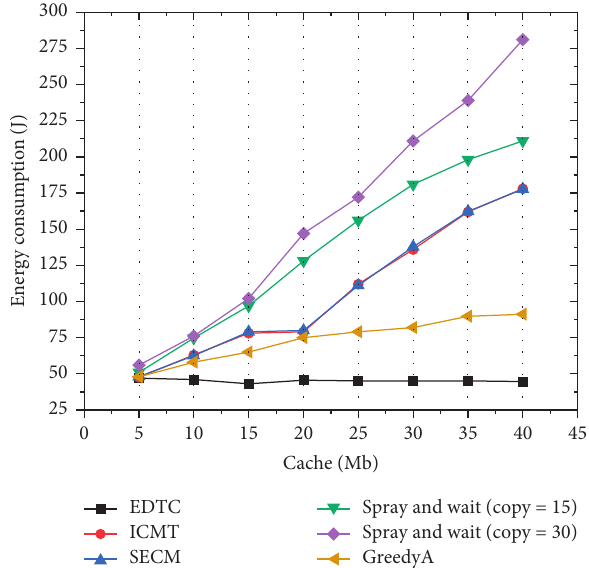
Figure 18: Relationship between energy consumption and cache.